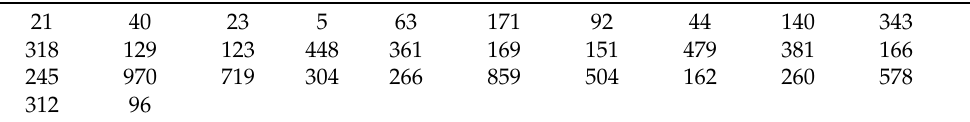
Table 13. The losses from private passenger automobile insurance policies data.